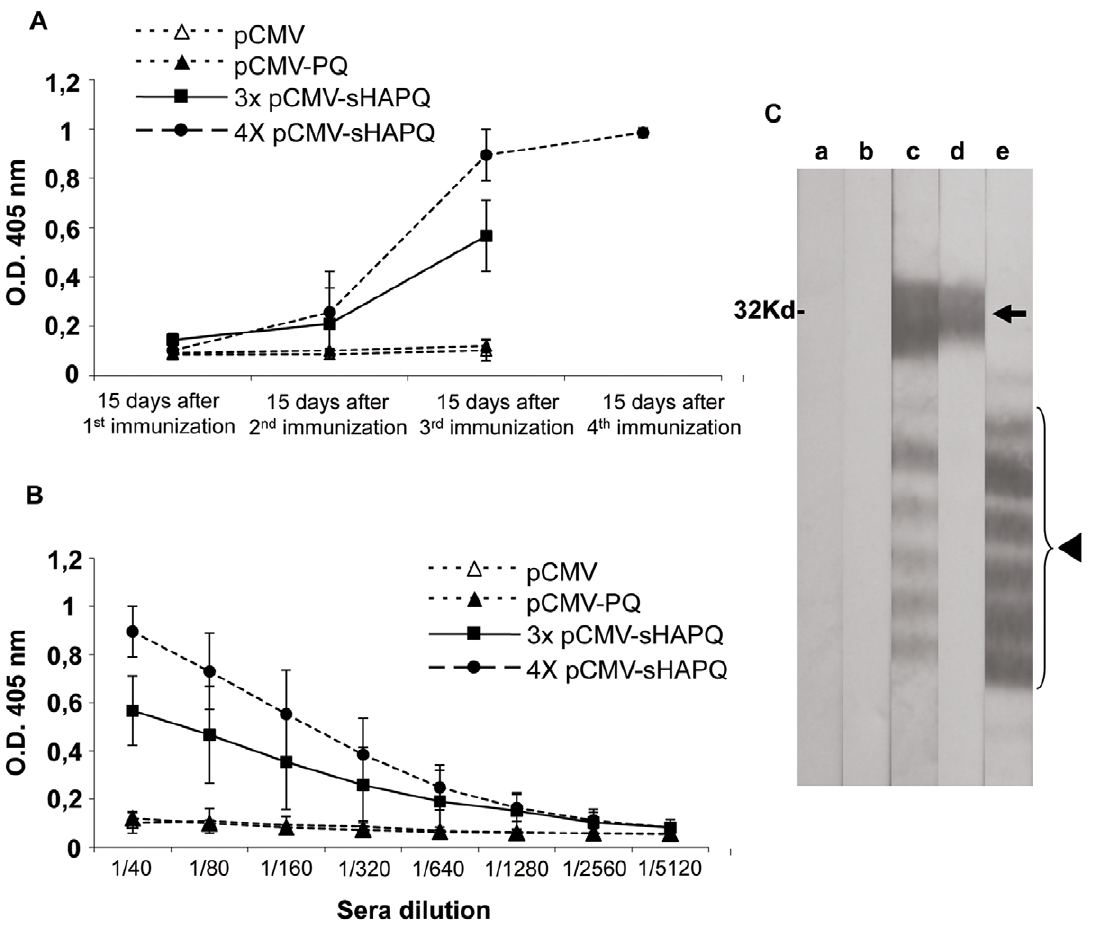
Figure 2. pCMV-sHAPQ induces specific antibody responses in pigs. 14 pigs were divided into three groups receiving either: the pCMV- sHAPQ plasmid (6 pigs), the pCMV-PQ plasmid (4 pigs) or the pCMV empty plasmid as controls for the assay (4 pigs). Four pigs from each group were immunized three times and two extra pigs from the pCMV-sHAPQ immunized-group received a fourth dose of this same plasmid. (A) Sera collected 15 days after each DNA vaccine administration were used to follow by ELISA the kinetics of the specific anti-p30 antibodies induced after DNA immunization. (B) Sera collected 15 days after the last DNA vaccination was used to ELISA-titrate the anti-p30 antibodies induced. Data shown correspond to average O.D values and standard deviations obtained per each immunization group. (C) Confirmatory Western-blot using ASFV infected cell extracts as antigen. Immunoreactive bands correspond to the specific recognition of the immunodominant p30 protein (arrow) and to the diverse p54 isoforms (arrow head) found in these extracts, ranging the last ones between 22 and 27 KD [65,66]. Figure shown corresponds to the results obtained with a representative serum (1:100 dilution) obtained 15 days after the third immunization with pCMV (a), pCMV-PQ (b) or pCMV- sHAPQ (c). The anti-p30 monoclonal antibody (d) and the specific polyclonal anti-p54 antibody (e) confirm the specificity of the reactions.